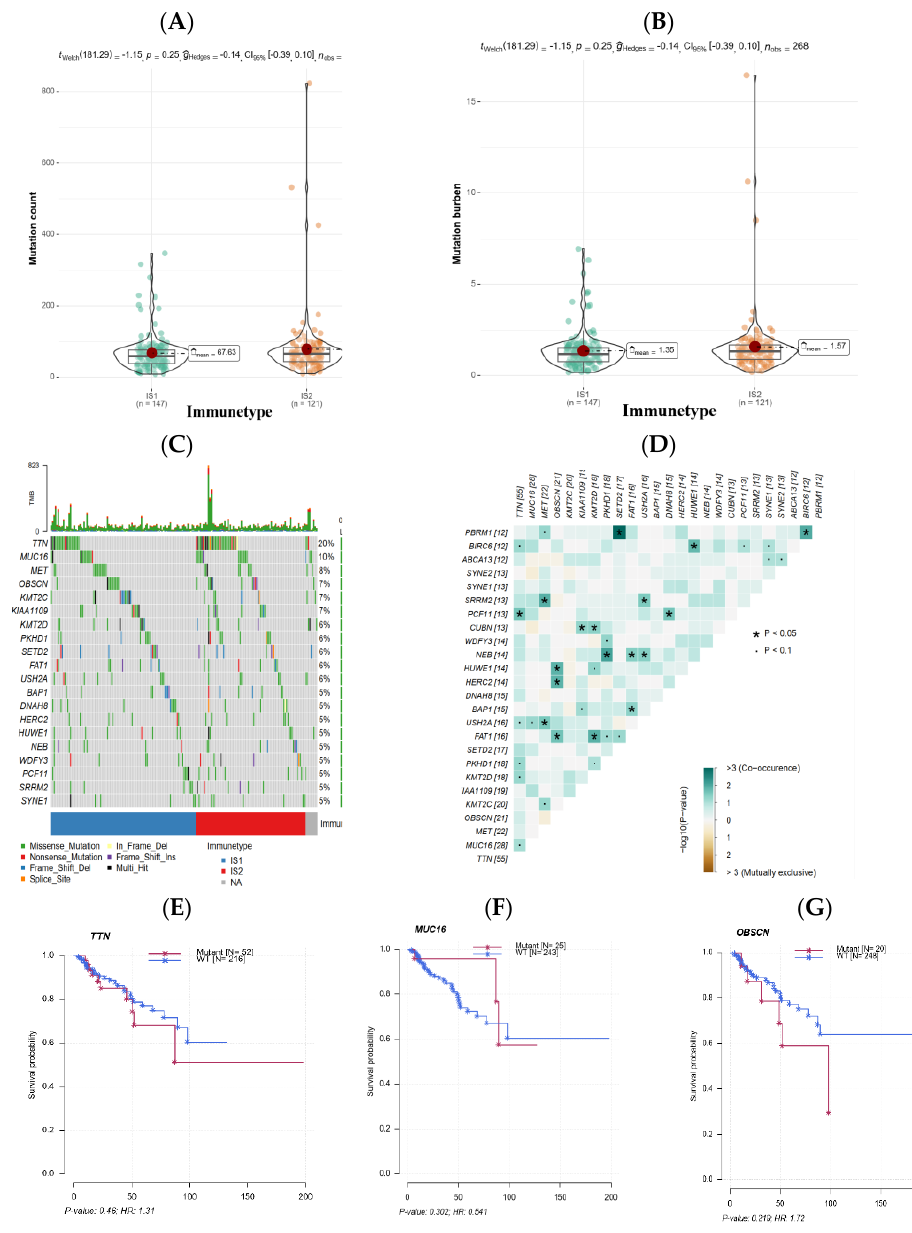
Figure 6. Mutation landscape of TCGA PRCC patients from different immune subtypes. ( A – B ) Mutation count and mutation burden evaluated in the two immune subtypes. ( C ) Top 20 genes in mutation frequency of the two subtypes. ( D ) The correlation of expression between most frequently mutated genes. ( E – G ) The survival diversity between the wild-type and mutant type of TTN, MUC16, and OBSCN.